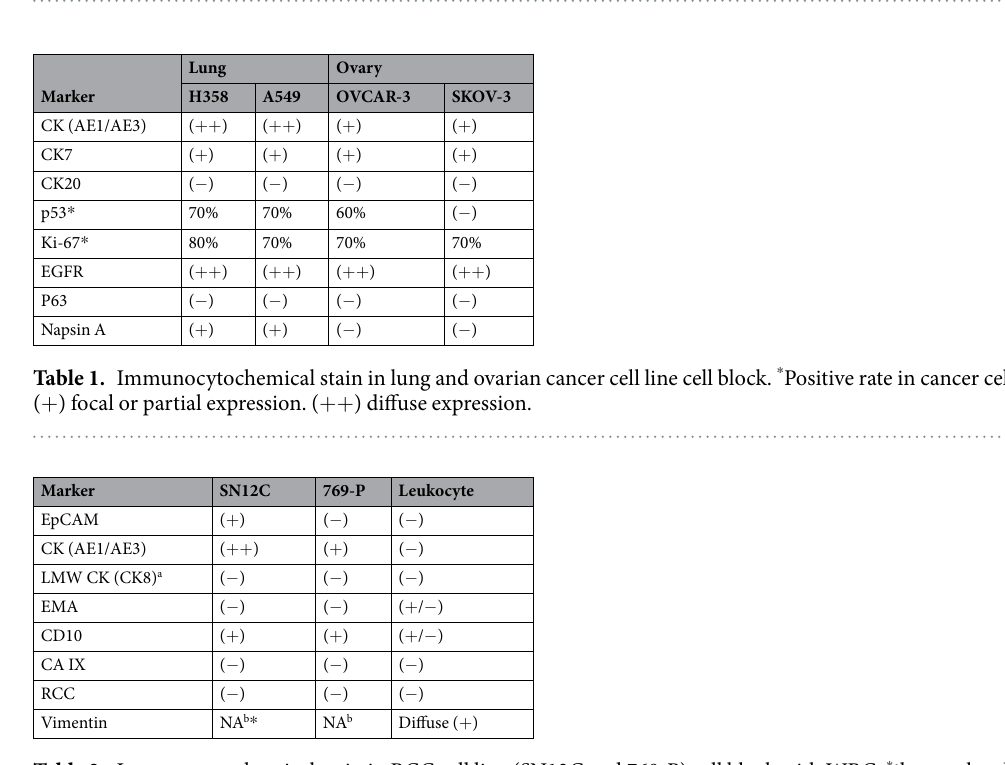
Table 2. Immunocytochemical stain in RCC cell line (SN12C and 769-P) cell block with WBC. * a low molecular weight Cytokeratin (Cytokeratin 8). b Not applicable: due to diffuse positivity in cancer cells as well as WBCs. + / − occasionally positive for B lymphocytes. + Focal or partial positivity. ++ Diffuse